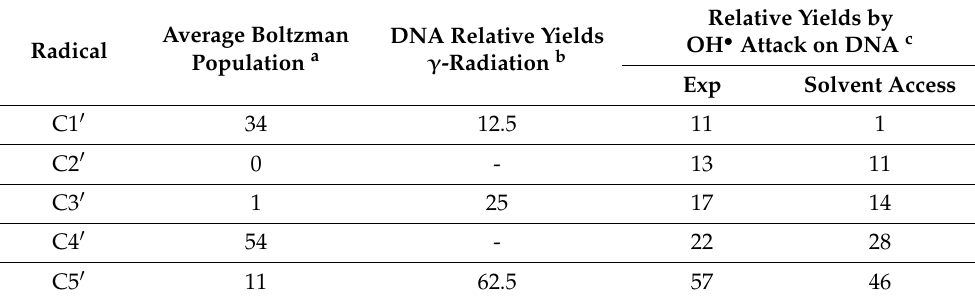
Table 3. Comparison of bond-energy-determined sugar radical populations with relative yields found by γ -irradiation as well as OH • attack. Values are given in %.